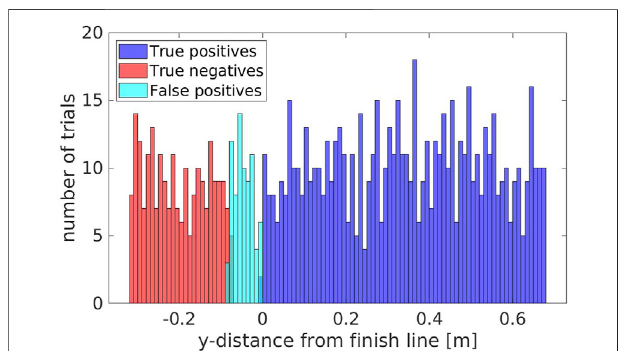
FIGURE13| Theamount oftrue positives/negatives and false positives/ negatives grouped with respect to the y-distance from the fi nish